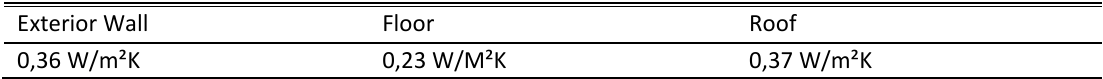
Table 4 U-Values of reference building envelopes for